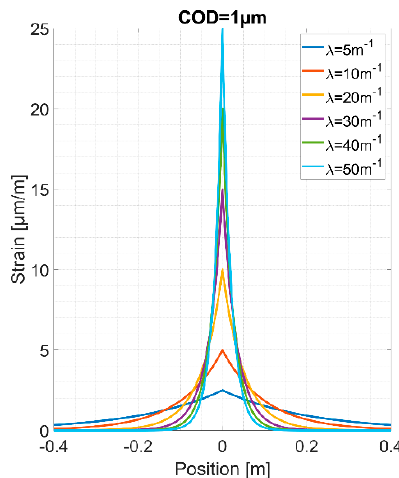
Figure 2. The spatial distribution form of the crack-induced strains ε crack (z) for different strain lag parameter λ values.